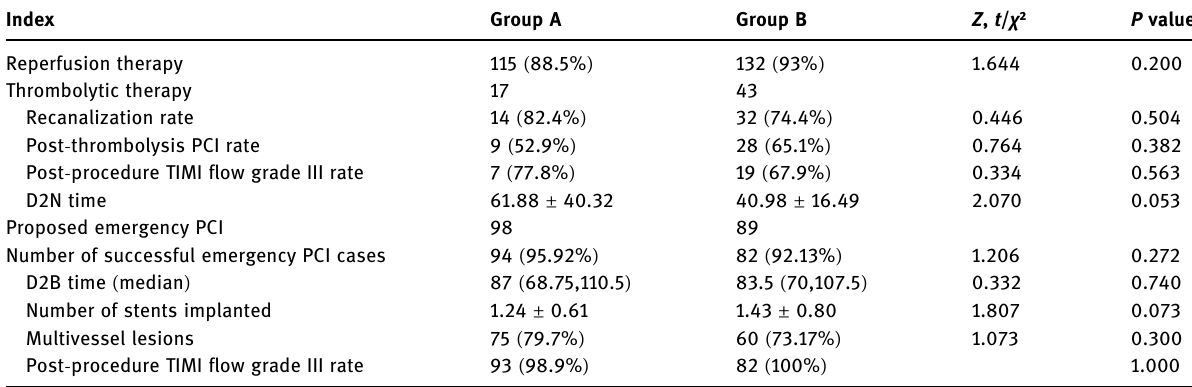
Table 3: Comparison of reperfusion treatments between groups ( %, Q1, Q3, mean ± SD